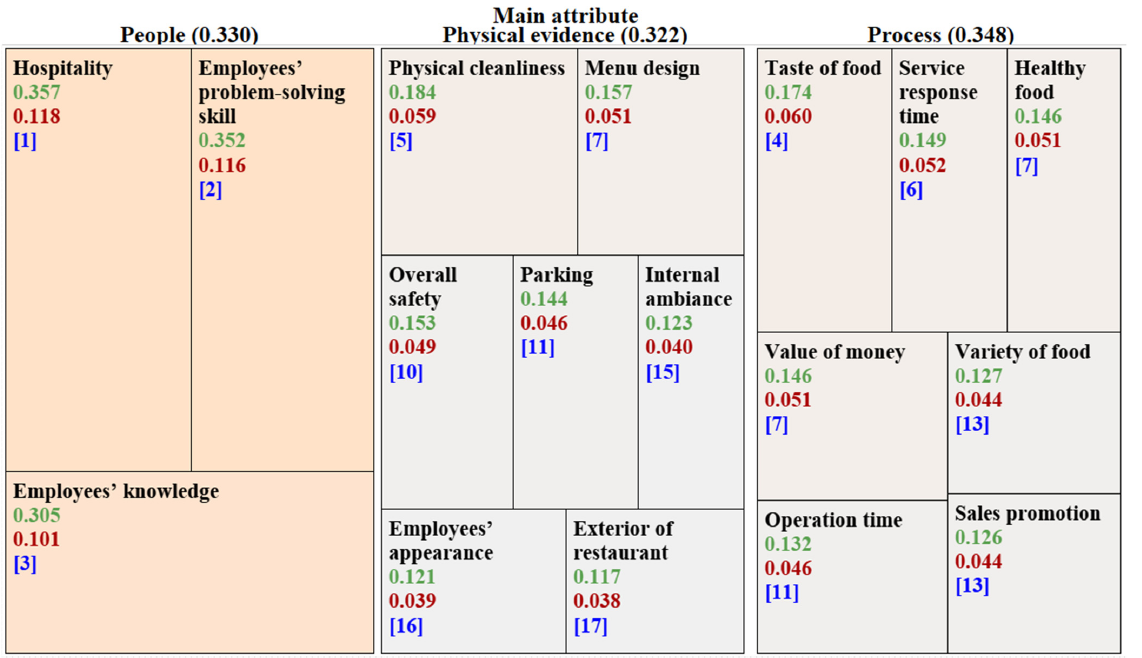
Figure 5. Tree map showing the weights of main and sub-attributes. A green, red, and blue value represents the sub-attribute’s local weight, global weight, and overall rank, respectively.